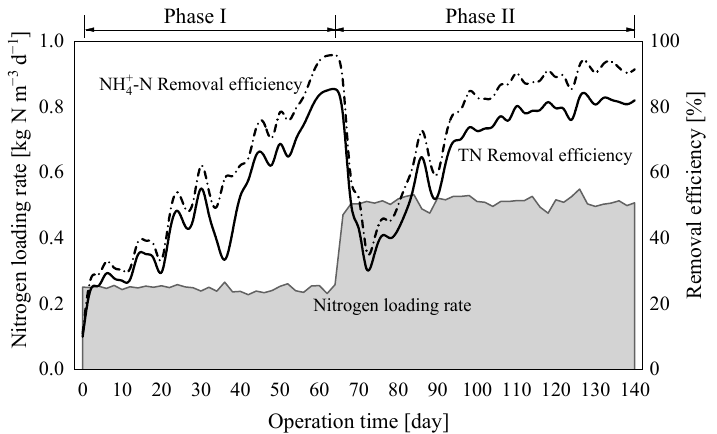
Figure 2. Reactor performance during the study period.